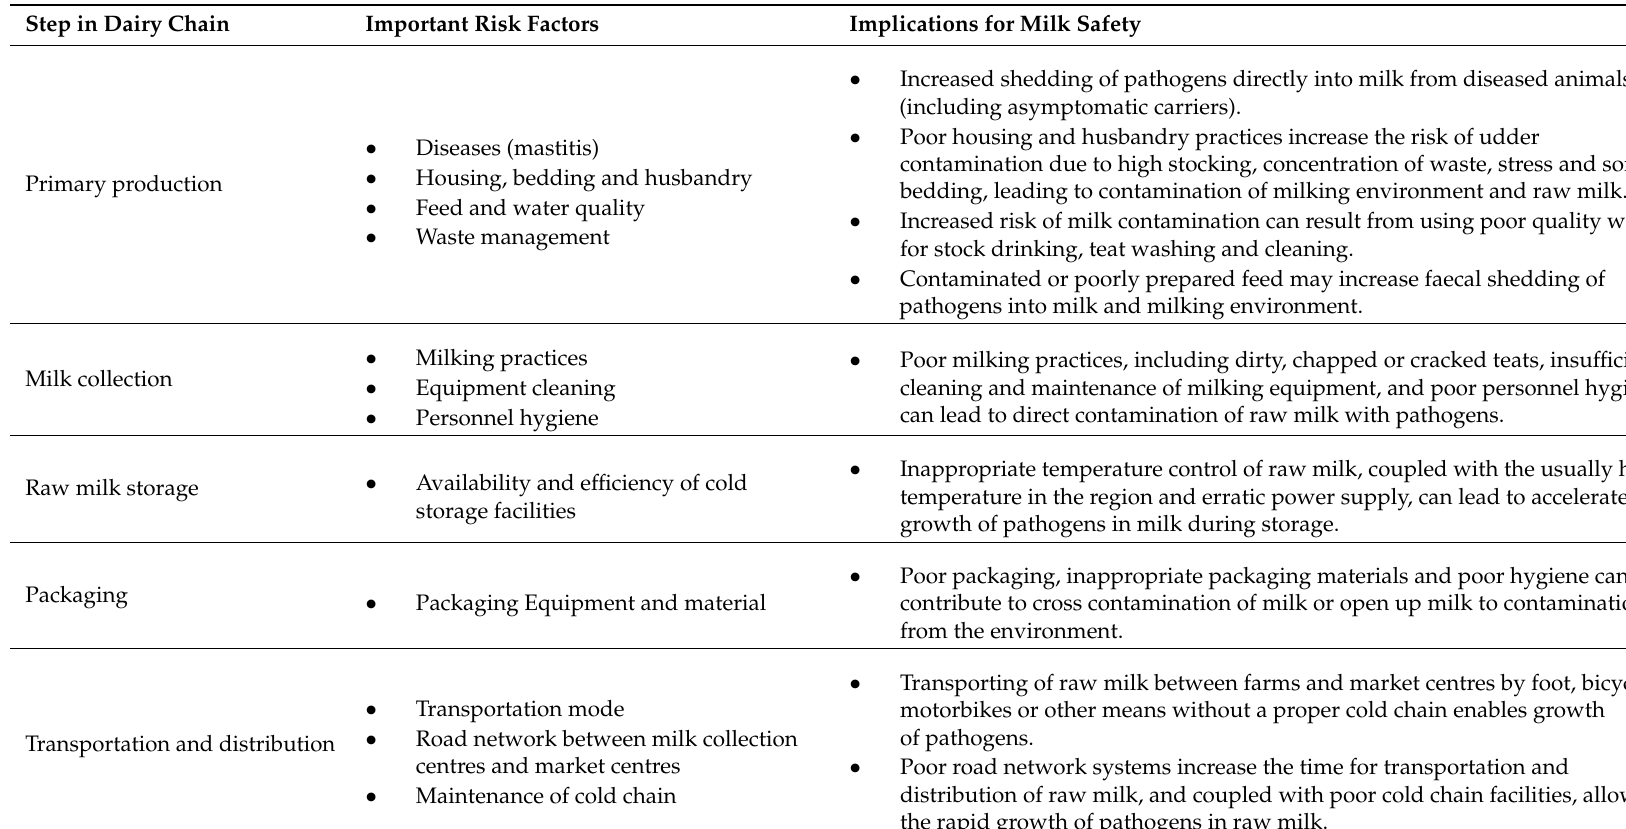
Table 2. Major microbiological risk factors and their implications for safety in the dairy chain in